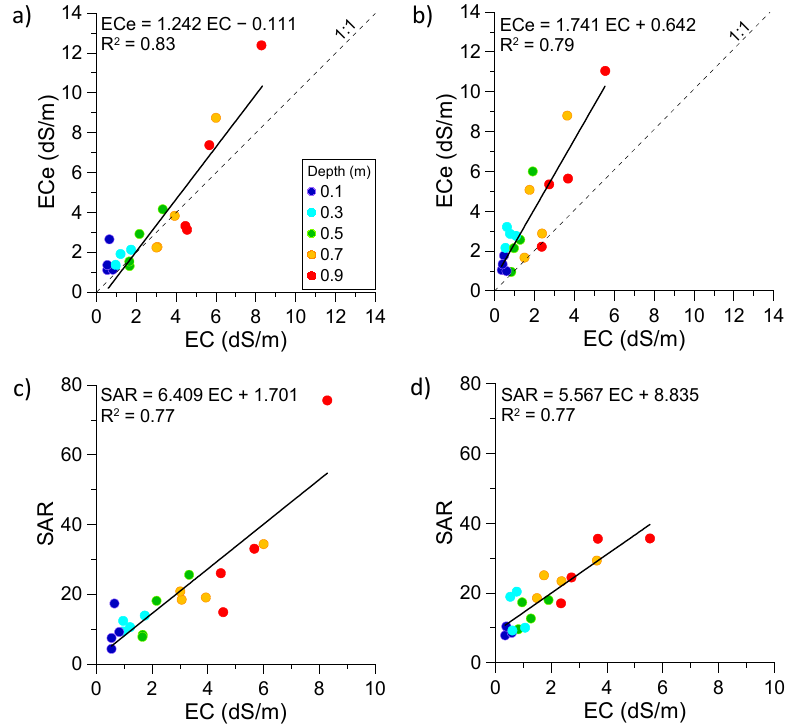
Figure 8. Relationships between ( a ) EC and saturated paste extract EC (ECe) for 2017 and ( b ) 2020 and between ( c ) EC and sodium absorption ratio (SAR) for 2017 and ( d ) 2020. Table 4. Leave-one-out cross validation parameters for the estimation of ECe and SAR in 2017 and 2020, distinguishing between top- (0.1 and 0.3 m layers) and subsoil (0.5–0.9 m